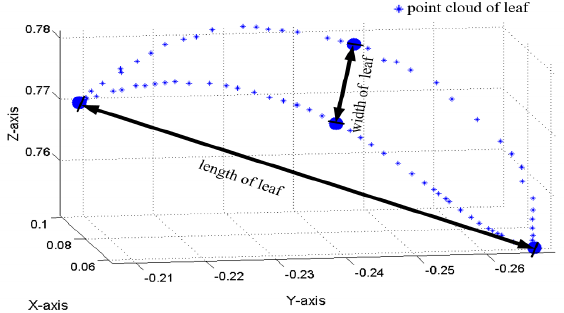
Figure 10. Fitting length and width of leaf with Euclidean distance